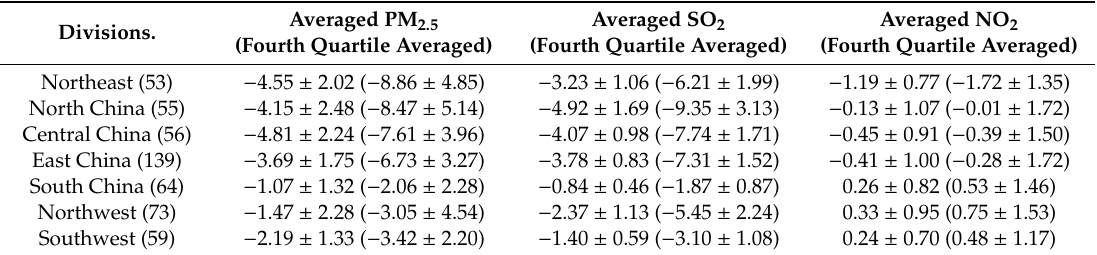
Table 1. Region-specific linear trends (mean ± 95% confidence interval) for PM 2.5 , SO 2 , and NO 2 from 2015 to 2018. The unit of trend is µ g / (m 3 · a). Numbers in brackets after division names are the total number of clustered stations in each division.